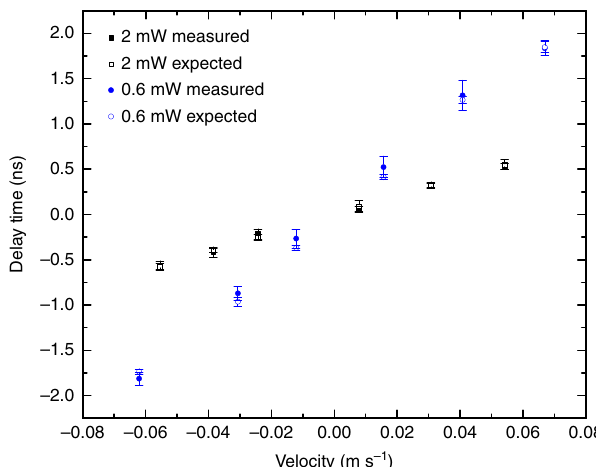
Figure 4 | Phase delay of the probe field with offset versus velocity of the atomic ensemble. The phase delay times from Fig. 3 are offset to zero at zero velocity. The solid circles (0.6mW control field power) and squares (2mW control field power) are the measured delayed phases and the open circles (0.6mW control field power) and squares (2mW control field power) are the expected delayed phases from equation 4 and group delay